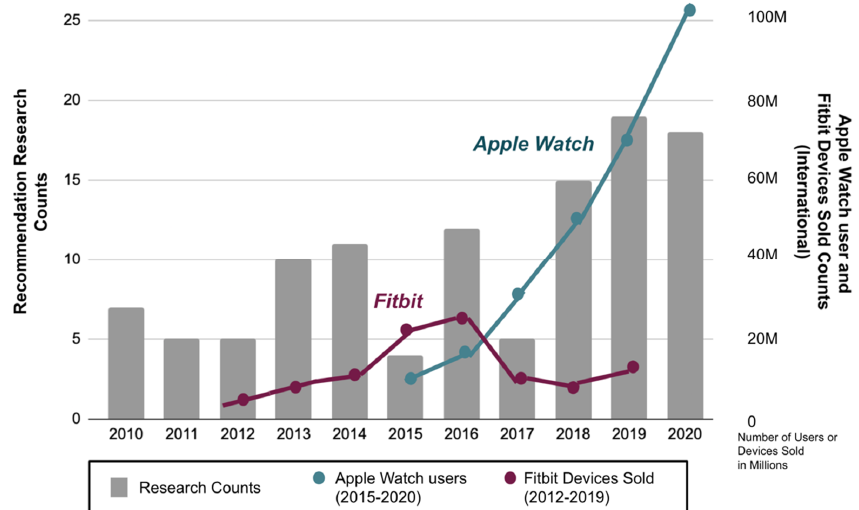
Figure 28. Trends in healthcare service field research from 2010 to 2021 and the number of users of Apple Watch and Fitbit, representative healthcare-related wearable devices.